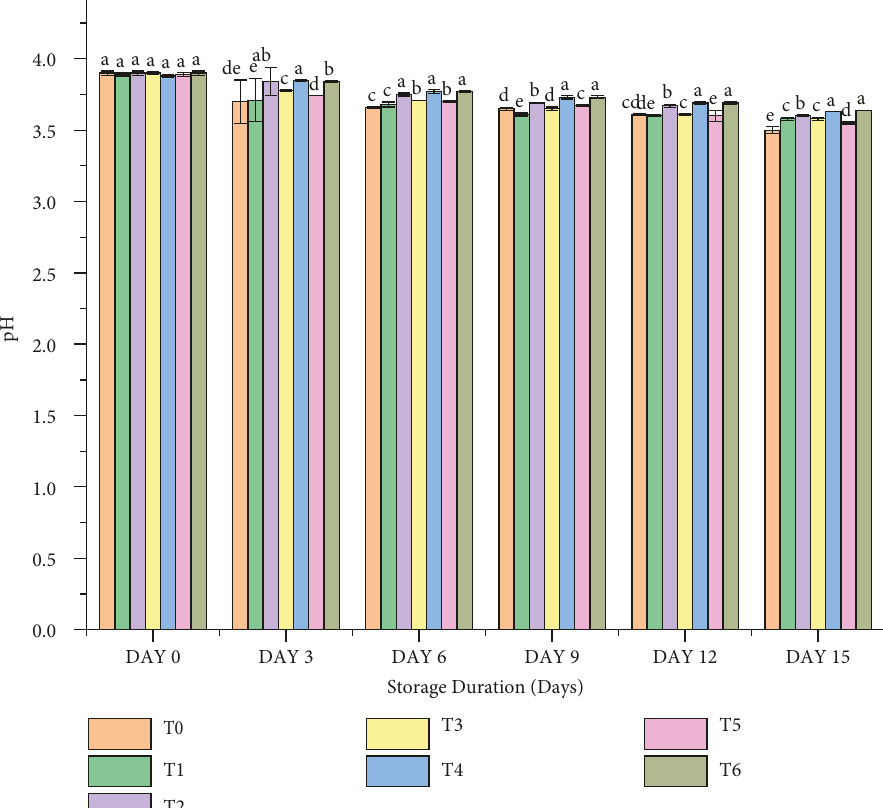
Figure 4: Effect of chitosan coating and cinnamon essential oil on pH of pomegranate arils during storage at 4 ± 1 ° C. Vertical bars represent the mean ± SD of 3 replicates. Error bars with different letters on the same storage period show a significant difference ( P ≤ 0 . 05). T0 � control; T1 � 1% chitosan+0.25% oil; T2 � 1% chitosan+0.5% oil; T3 � 2% chitosan+0.25% oil; T4 � 2% chitosan+0.5% oil; T5 � 3% chitosan+0.25% oil; T6 � 3% chitosan+ 0.5%